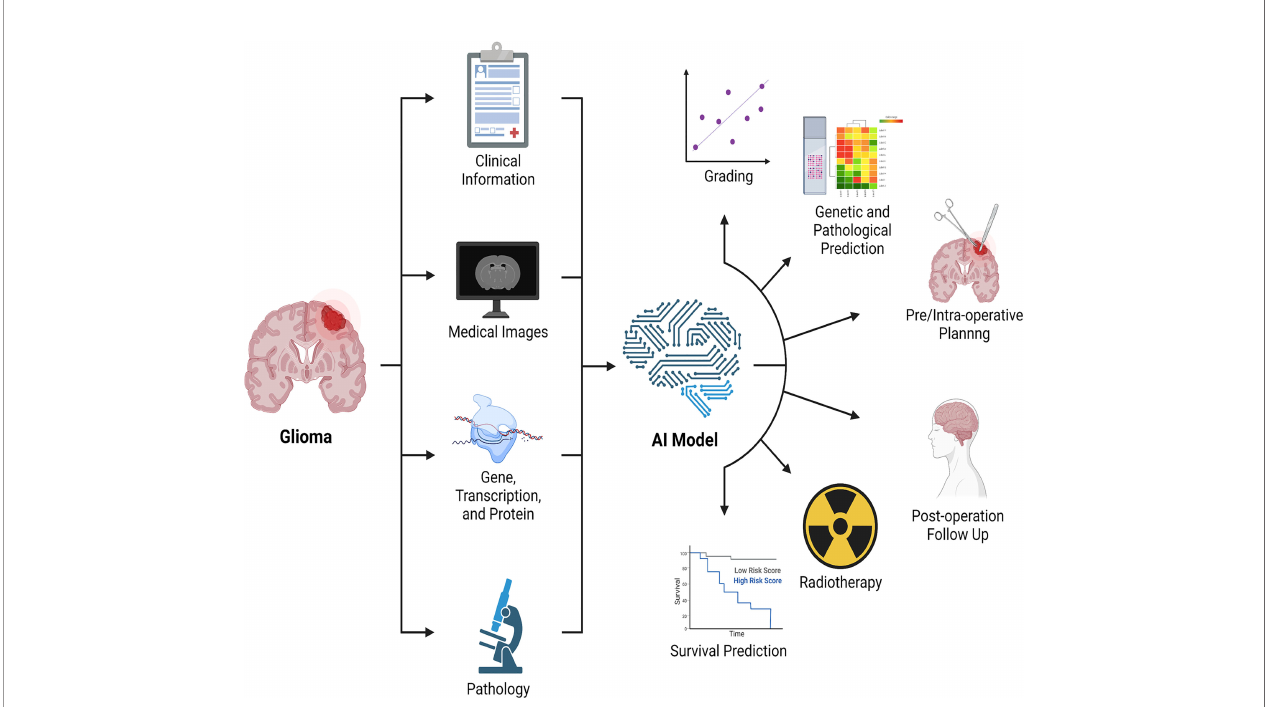
FIGURE 3 | Combination of multi-omics analysis and arti fi cial intelligence. Arti fi cial intelligence integrates clinical data, medical imaging, genomics, transcriptomics, proteomics, and pathology, among other things, to enable the application of multiple omics in glioma, with the potential to detect and evaluate lesions, promote treatment, and predict treatment response and prognosis. AI: arti fi cial